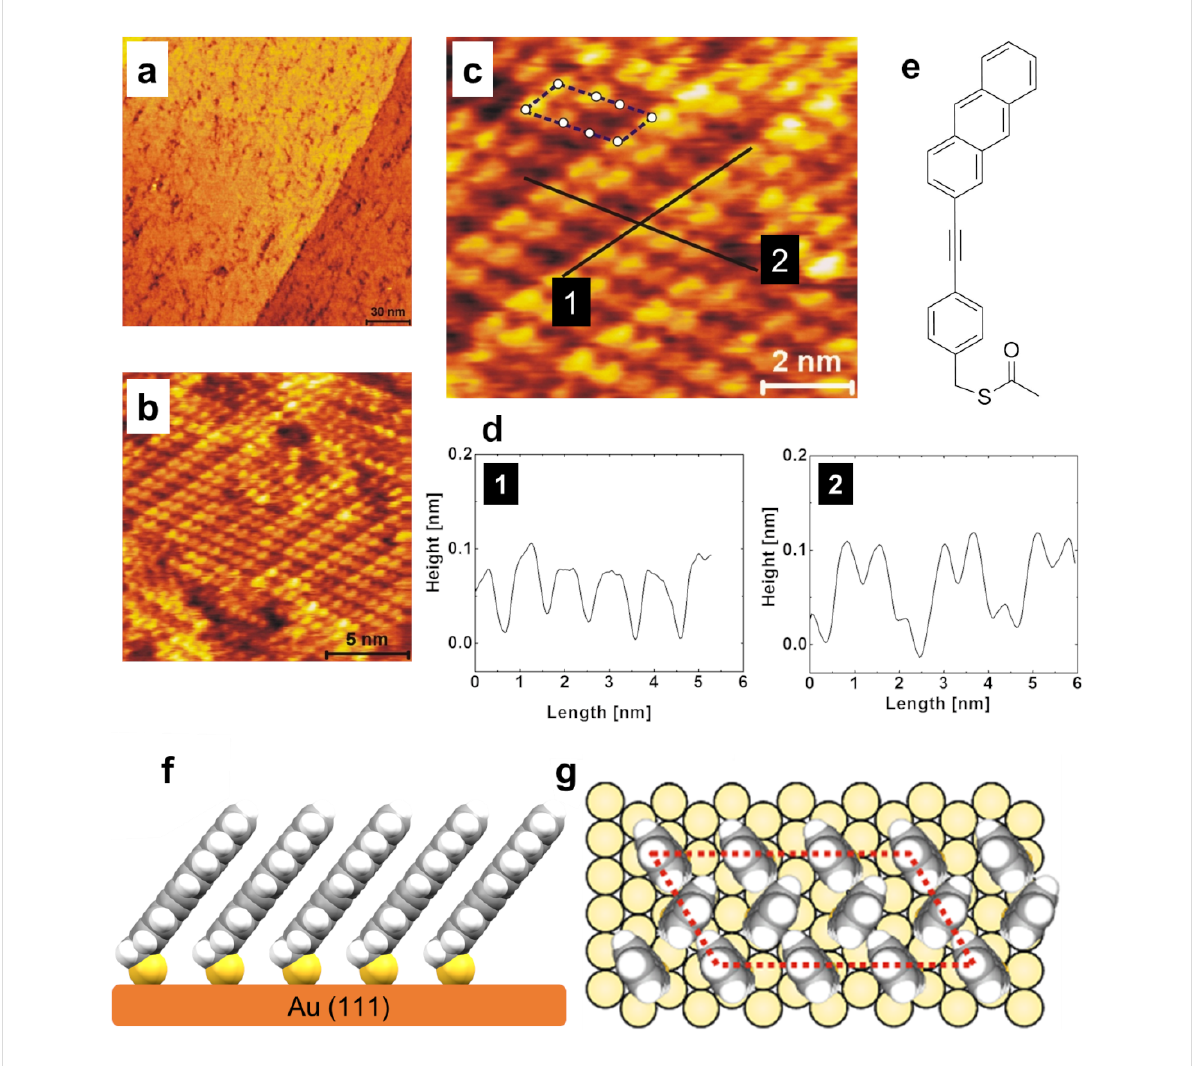
Figure 1: (a), (b) and (c) show STM height images of a PAT SAM on gold at different magnifications describing the molecular structure of the SAM. The unit cell is marked as a parallelogram in (c) with a single domain with the structure (2 √ 3 × 4 √ 3) R 30°. (d) The height profiles along the two lines in the topography image of (c) labeled with 1 and 2. (e) Structural formula of the compound used to prepare the PAT SAMs, and (f) the schematic side- view illustration of the aligned adjacent molecules in the PAT SAM. (g) A top-view hard sphere structure model of the PAT-SAM.